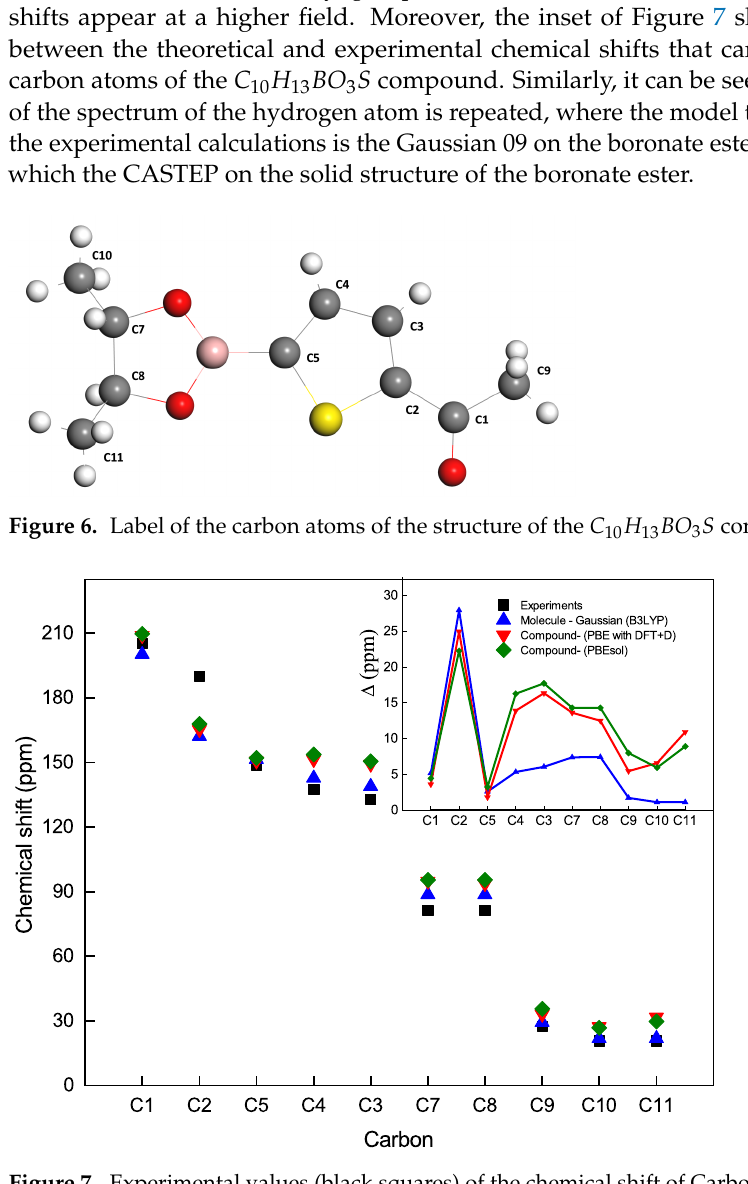
Figure 7. Experimental values (black squares) of the chemical shift of Carbon NMR-13C with respect to the values calculated with different methods; B3LYP (blue triangle) in Gaussian on the molecule of boronate ester, PBE with DFT+D (red triangle) and PBEsol (diamond green) in CASTEP on the periodic lattice of the C 10 H 13 BO 3 S compound. Inset: Deviation of the theoretical values respect to the experimental data, ∆ = | CS th − CS ex | , as a function of the Carbon